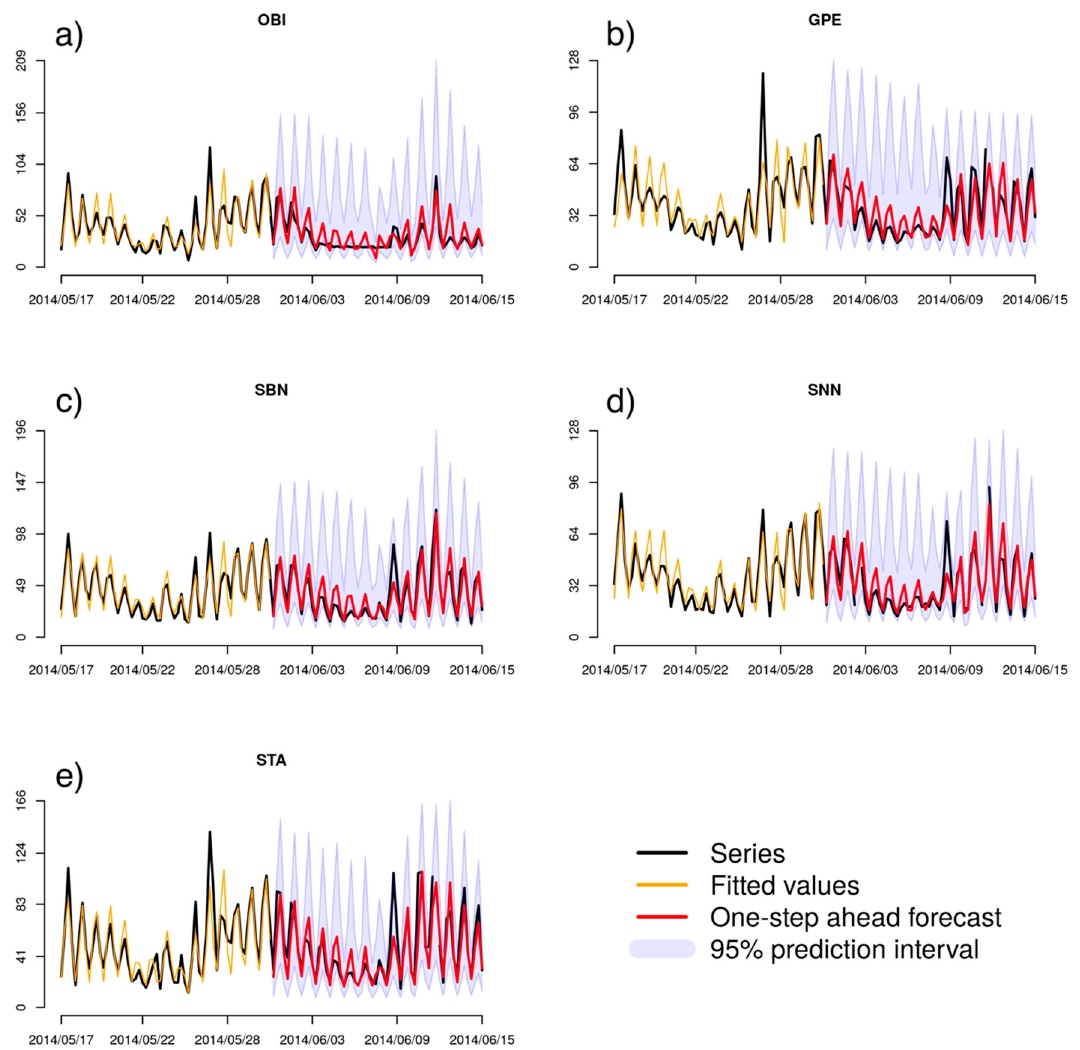
Figure 5. Forecast performance with the original scale in the last two weeks of the sample (fitted values) and in the first two weeks out of the sample (one-step ahead forecasts) for the five analyzed monitoring sites in the MMA: ( a ) OBI, ( b ) GPE, ( c ) SBN, ( d ) SNN and ( e ) STA. Fitted values and forecasts behave similarly. Prediction intervals (95%) are computed for the logarithmic scale and then transformed back to the original scale. The forecast performance does not appear to decay in the left-out sample.